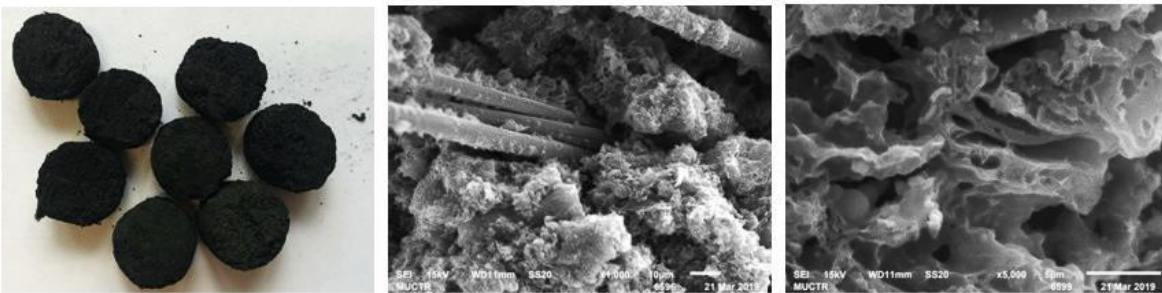
Figure 8. Photographs of activated carbon pellets with the addition of 1% recovered CF at magnification×1, ×1000 and ×5000